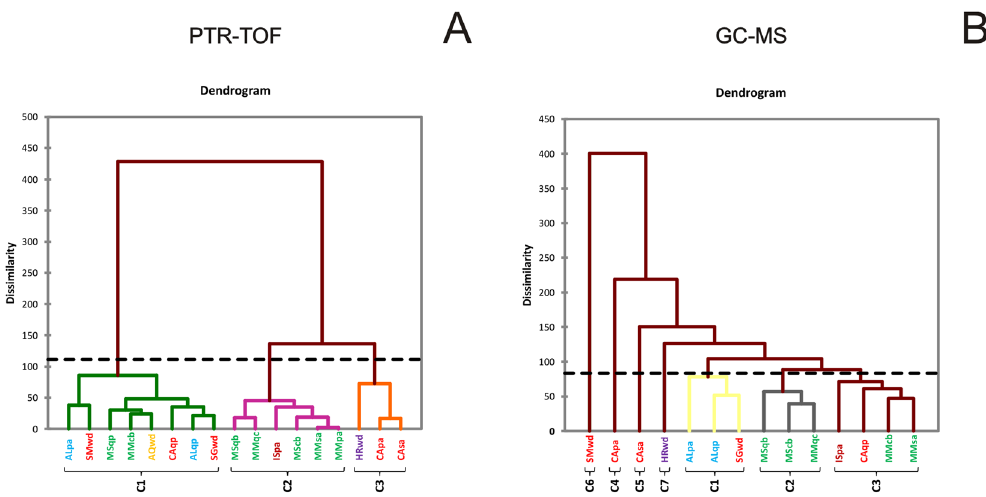
Figure 3. Results of aggregative hierarchical clustering (AHC) performed on PTR-TOF ( A ) and GC-MS data ( B ). C1-C7: Sample distribution classes, based on their dissimilarity coefficient. The dotted line represents the degree of truncation of the dendrogram used for creating classes and was automatically chosen based on the entropy level. The sample list is shown in Table